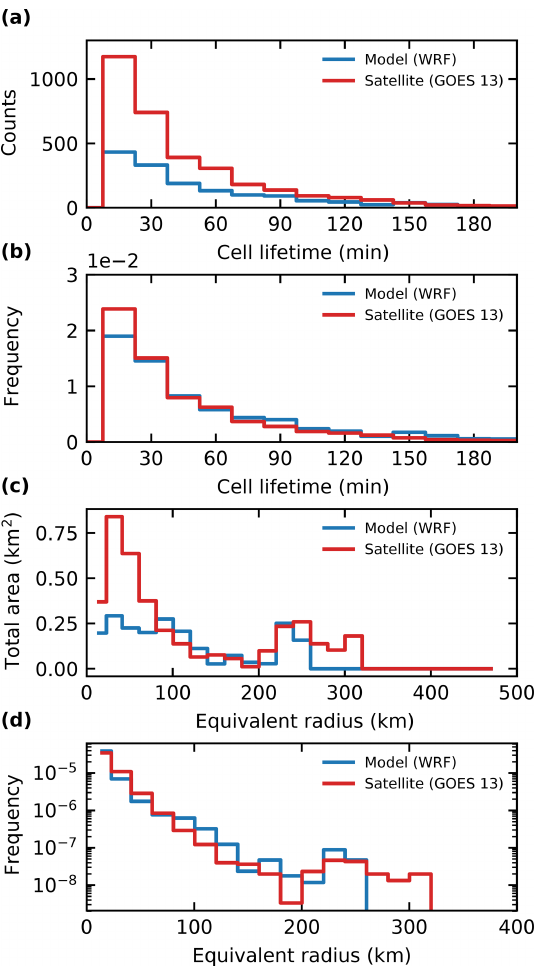
Figure 10. Distributions of cloud lifetimes obtained from the track- ing of model data and satellite retrievals, shown as total counts (a) and frequency (b) . The distribution of cloud areas is shown as the distribution of total area resulting from the sum in each area bin (d) and as a PDF of cloud area (c) . Both these distributions are plot- ted against the equivalent radius of a circular cloud of the same area.